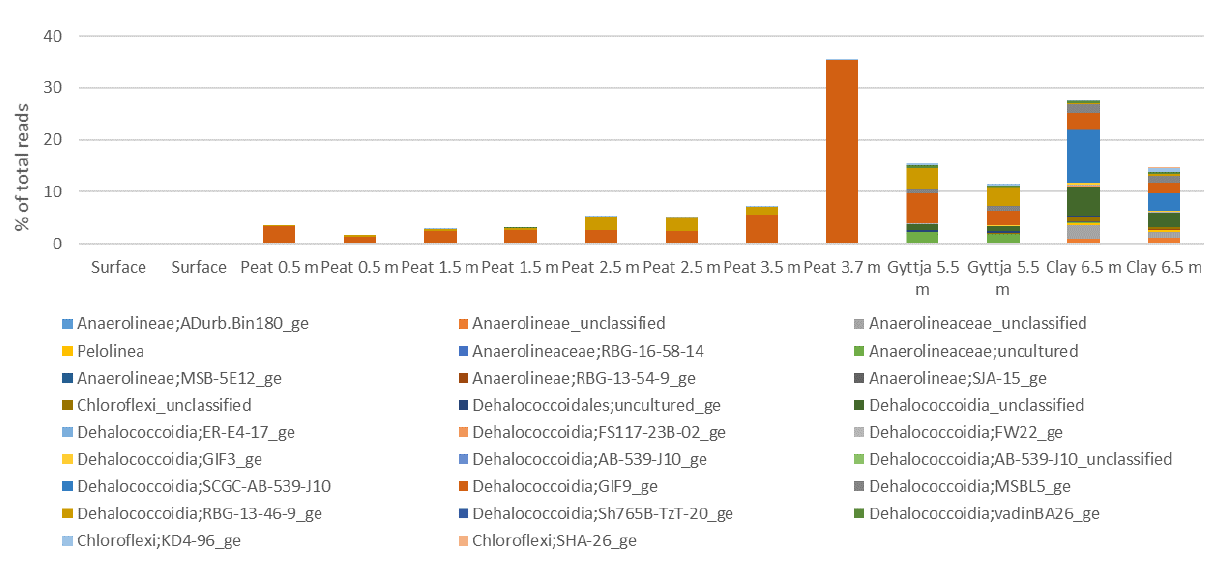
Figure A6. The relative abundance of Gammaproteobacterial genera in Lastensuo Bog samples.